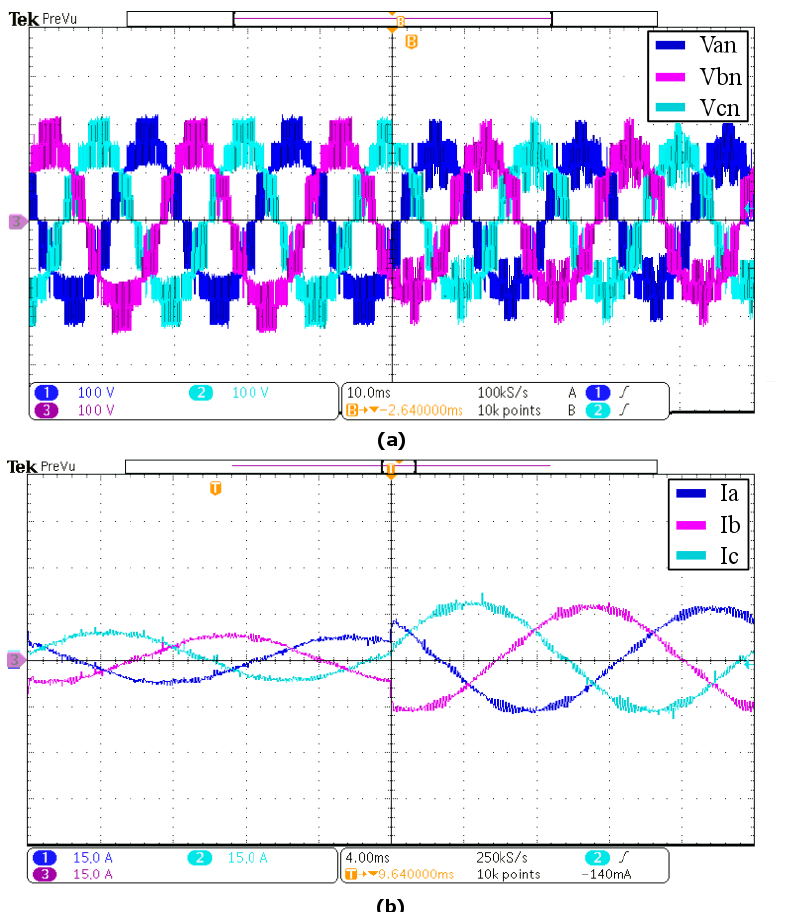
Figure 25. Variations in power transfer. ( a ) Experimental waveform of phase voltages tracing channels 1, 2, 3 (100 V/div). ( b ) Experimental validation of converter current tracing channels 1, 2, 3